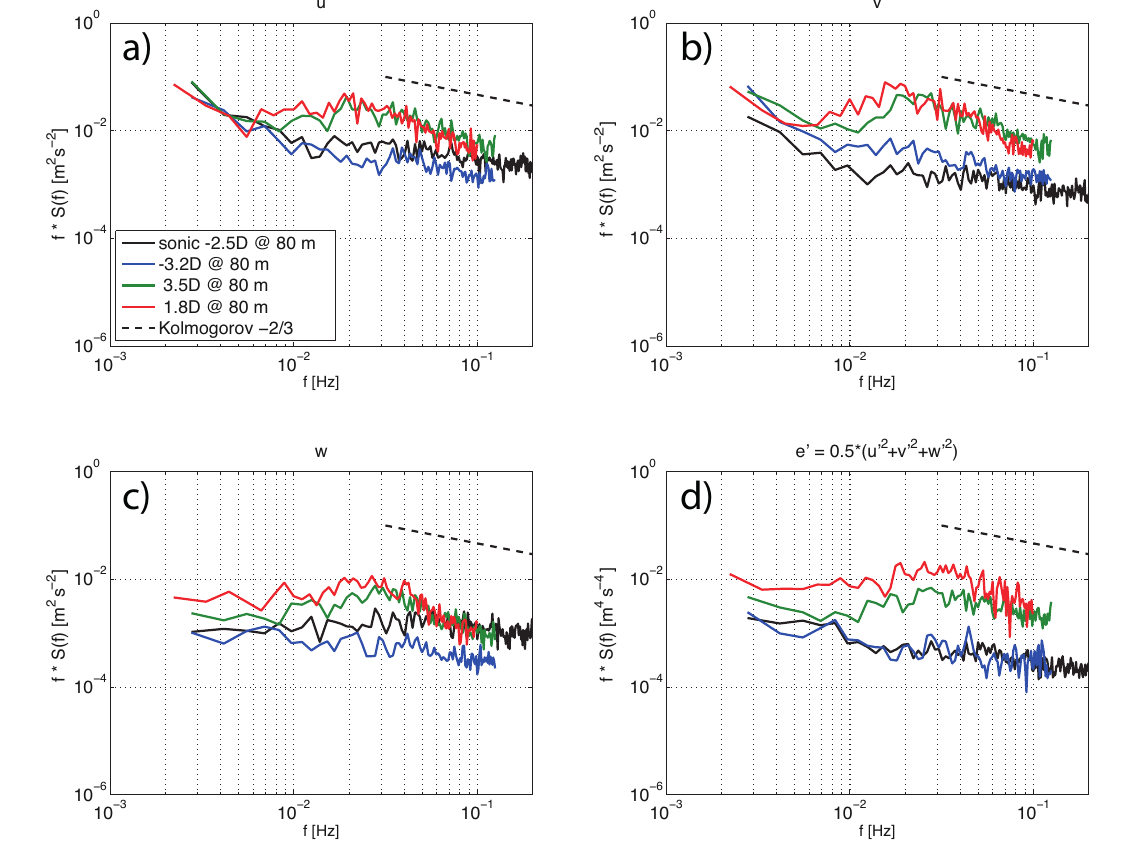
Figure 8. Energy spectra of four hours on 4 March 2014 in free stream (blue and black) and wake conditions (green and red) of the along-wind ( a ), cross-wind ( b ) and vertical component ( c ) u, v, w and TKE ( d ). Black colors show data from the sonic anemometer and blue; red and green colors show Windcube wls67, Windcubes wls37 and wls65 data at 80 m (hub height). The dashed line indicates the − 2/3 Kolmogorov